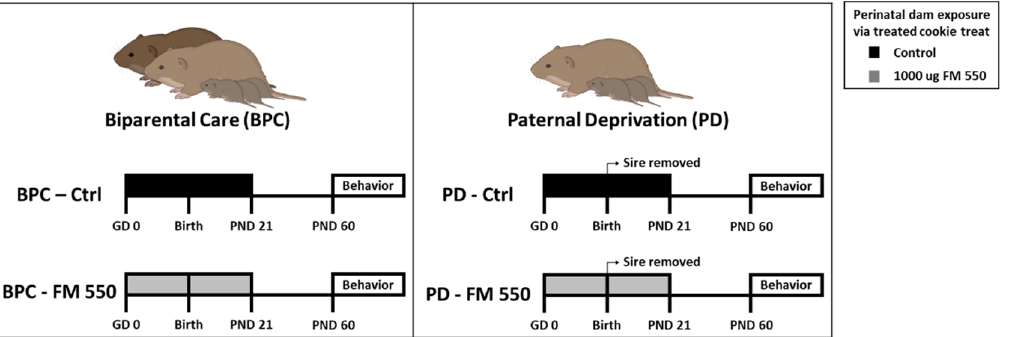
Figure 1. Study design.